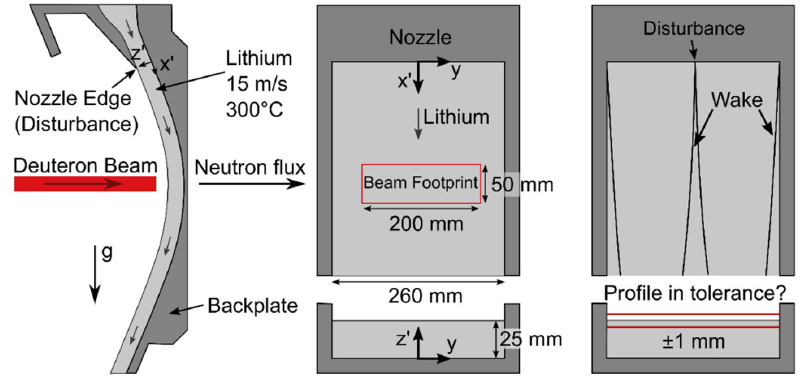
Figure 1. Sketch of the DONES target.